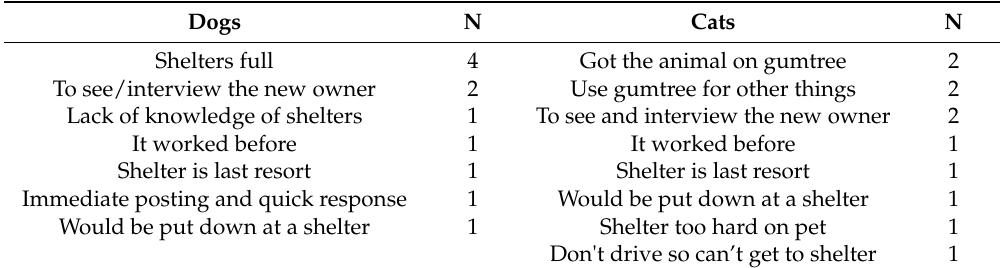
Table 9. Reasons people gave for choosing to advertise their relinquished pet on